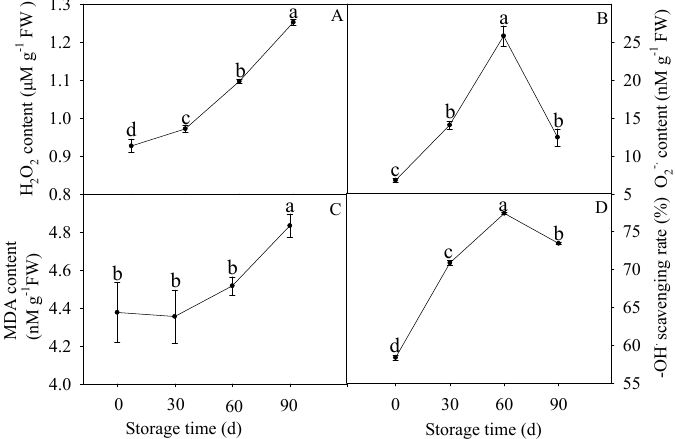
Figure 4. Changes in H 2 O 2 content ( A ), O 2 − content ( B ), malondialdehyde (MDA) content ( C ), and –OH scavenging rate ( D ) in postharvest pumelos during storage at 25 °C. Each data point was shown as the mean ± standard error (SE). Different letters indicated significant difference ( p < 0.05).